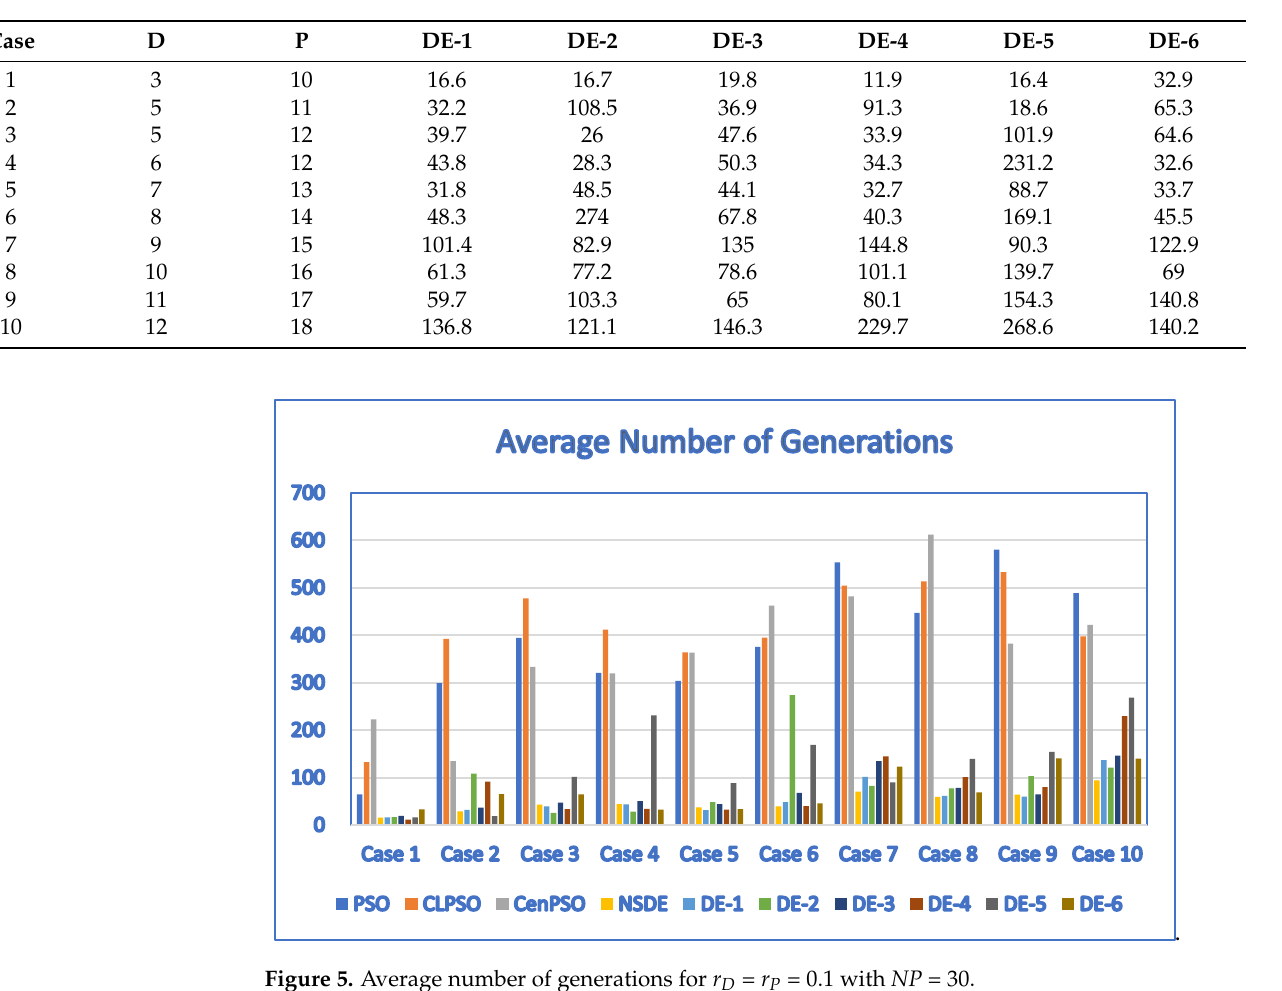
Figure 5. Average number of generations for D r = P r =0.1 with NP = 30.